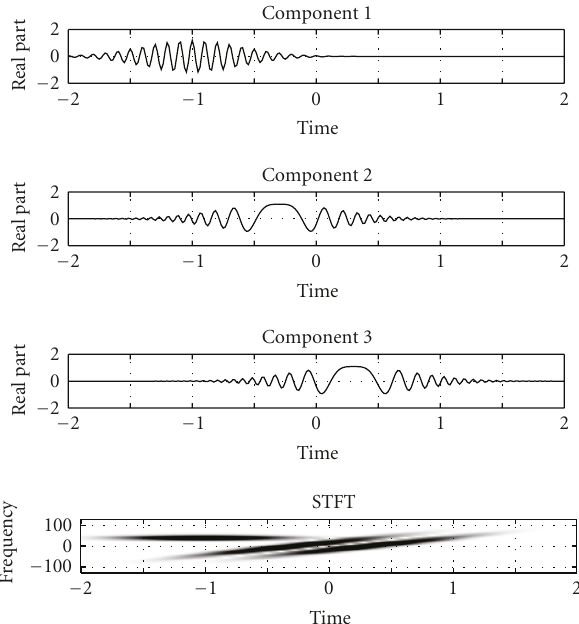
Figure 2: The Multicomponent signal example Ex3 with 3 compo- nents.